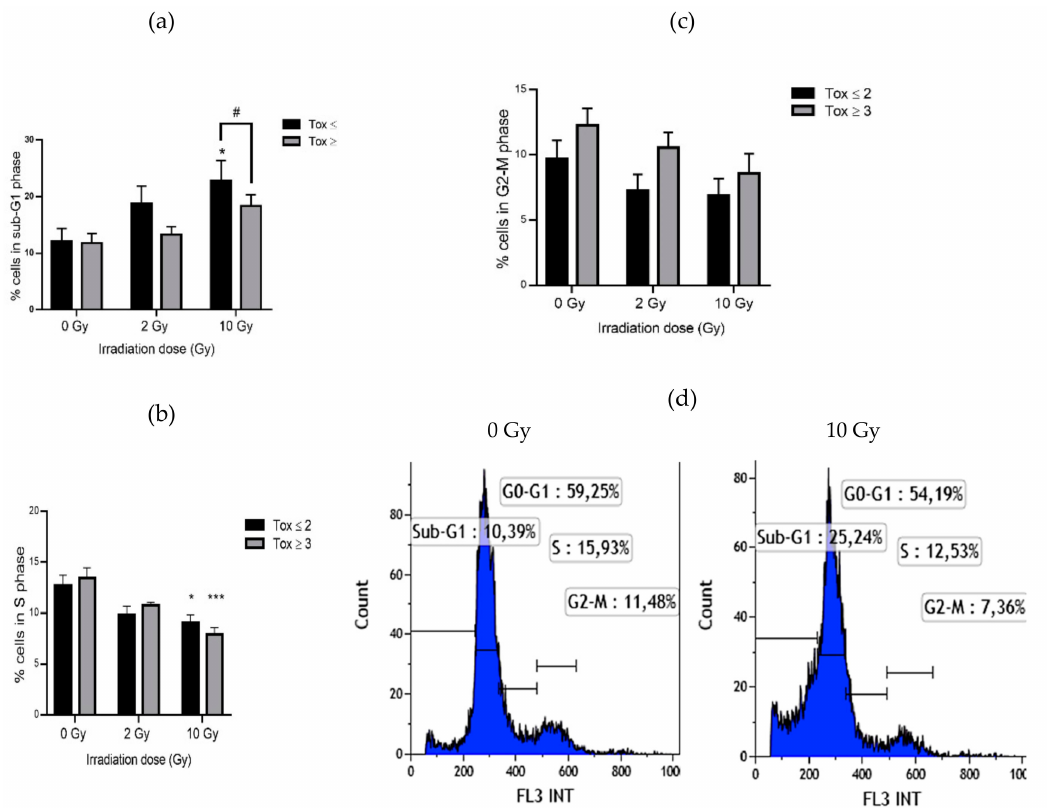
Figure 2. Lymphocyte percentage in sub-G1 phase ( a ), in S phase ( b ) and in G2-M phase ( c ) in both groups of patients and example of analysis of cell cycle for one patient ( d ). Groups Tox ≤ 2 and Tox ≥ 3 correspond to patients presenting grade 2 or less and grade 3 or more of late skin reactions after RT according to RTOG / EORTC, respectively. * for p < 0.05 and *** for p < 0.0001 for irradiated samples compared to non-irradiated ones and # for p < 0.05 for Tox ≥ 3 compared to Tox ≤ 2